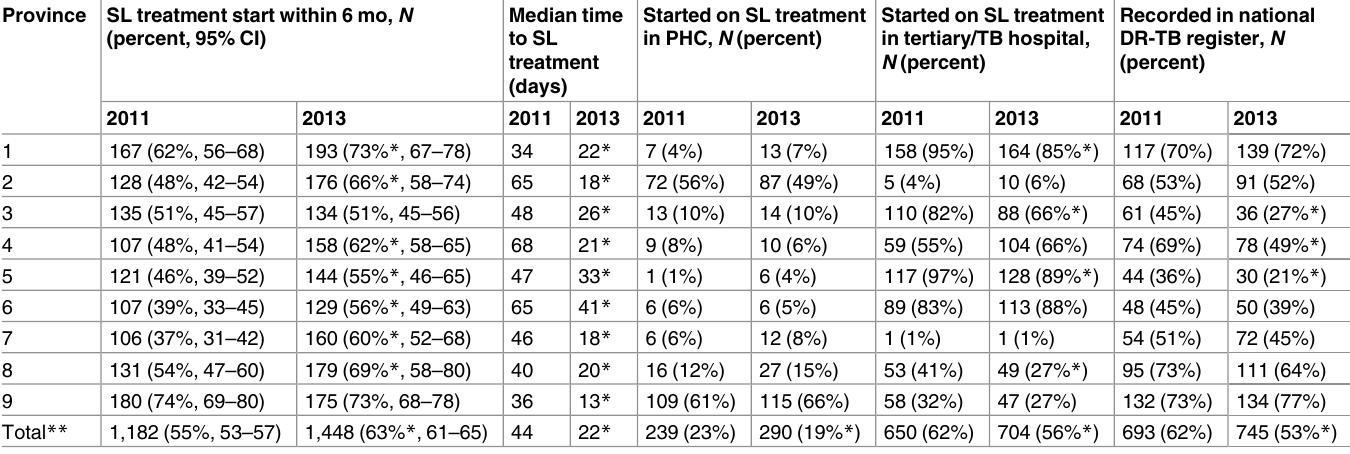
Table 3. Percentage of patients who initiated treatment, time to treatment, site of treatment initiation, and recording in national drug-resistant tuberculosis register by cohort and province (new rifampicin-resistant tuberculosis patients). Province SL treatment start within 6 mo, N (percent, 95% CI)